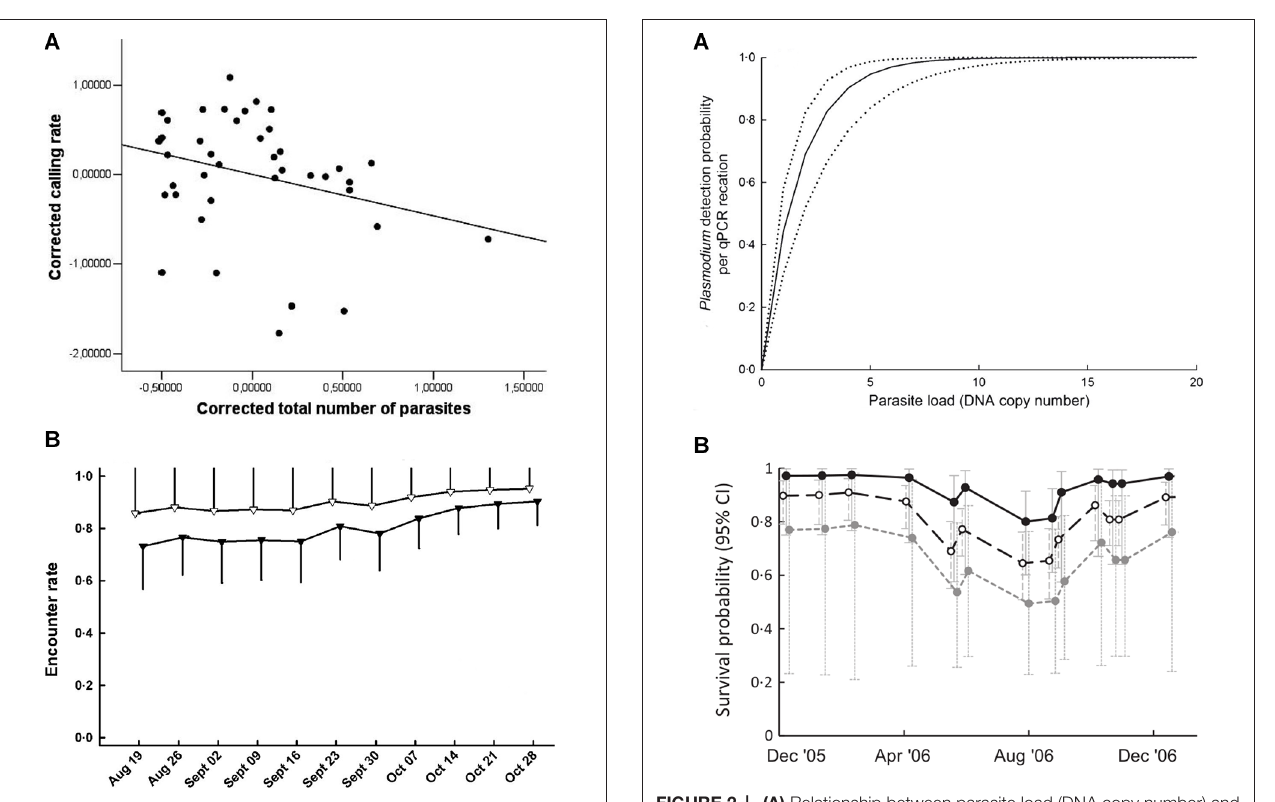
figURe 1 | (a) Calling rate of treefrogs ( Hypsiboas prasinus ) versus total number of helminth parasites. Corrected calling rate and total number of parasites are the residuals of a regression of body mass; the line is illustrative ( Adapted from Madelaire et al. ( 23 ), with permission from the Journal of Herpetology ); (B) Encounter rate of house finches that were infected with Mycoplasma gallisepticum (black triangles) or not infected (white triangles) [Adapted from Faustino et al. ( 7 ), with the permission of John Wiley and Sons ].